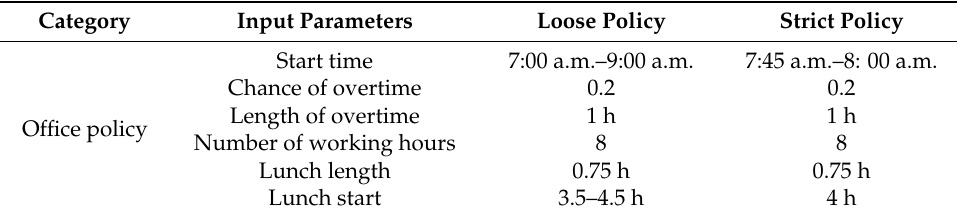
Table 3. Input parameters for a loose and a strict office policy.